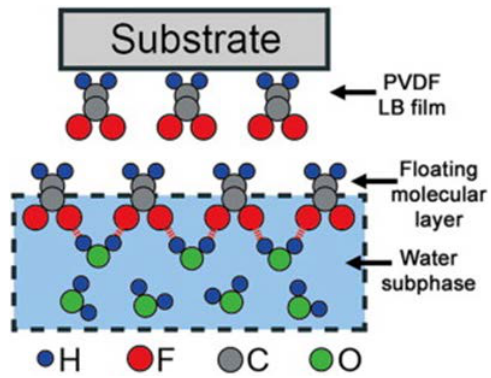
Figure 5. Schematic illustration of the oriented PVDF molecules and the subsequent transfer to form the LB film on a substrate [58].